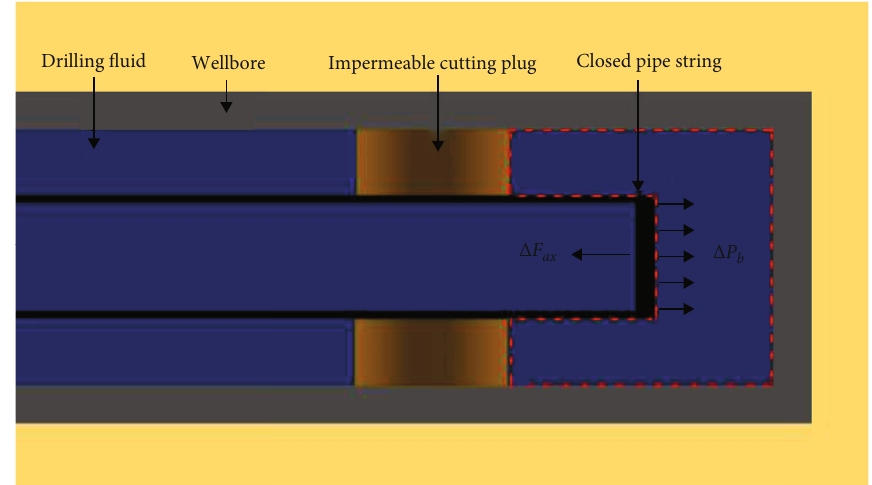
Figure 3: A closed pipe string with an impermeable cutting